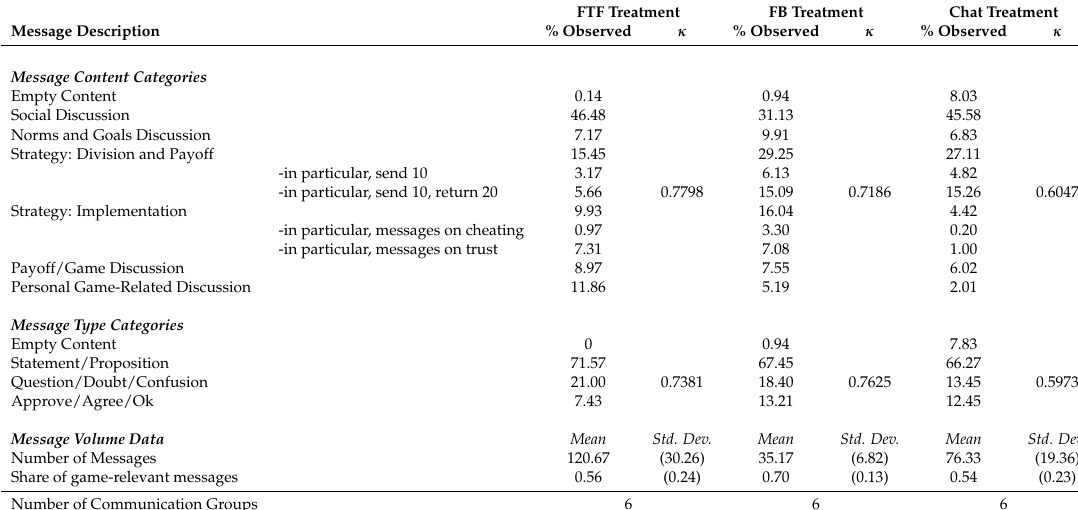
Table 8. Communication content by